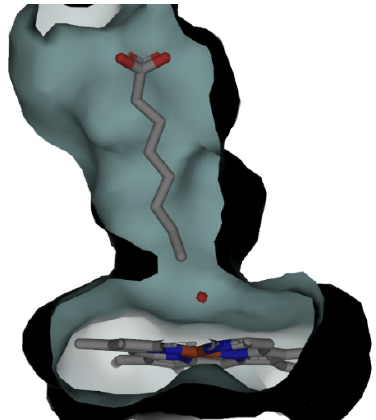
Figure 7. Surface rendering of CYP153A71 with bound n ‐ octanoic acid displaying the tapered ac ‐ tive ‐ site substrate ‐ access channel.